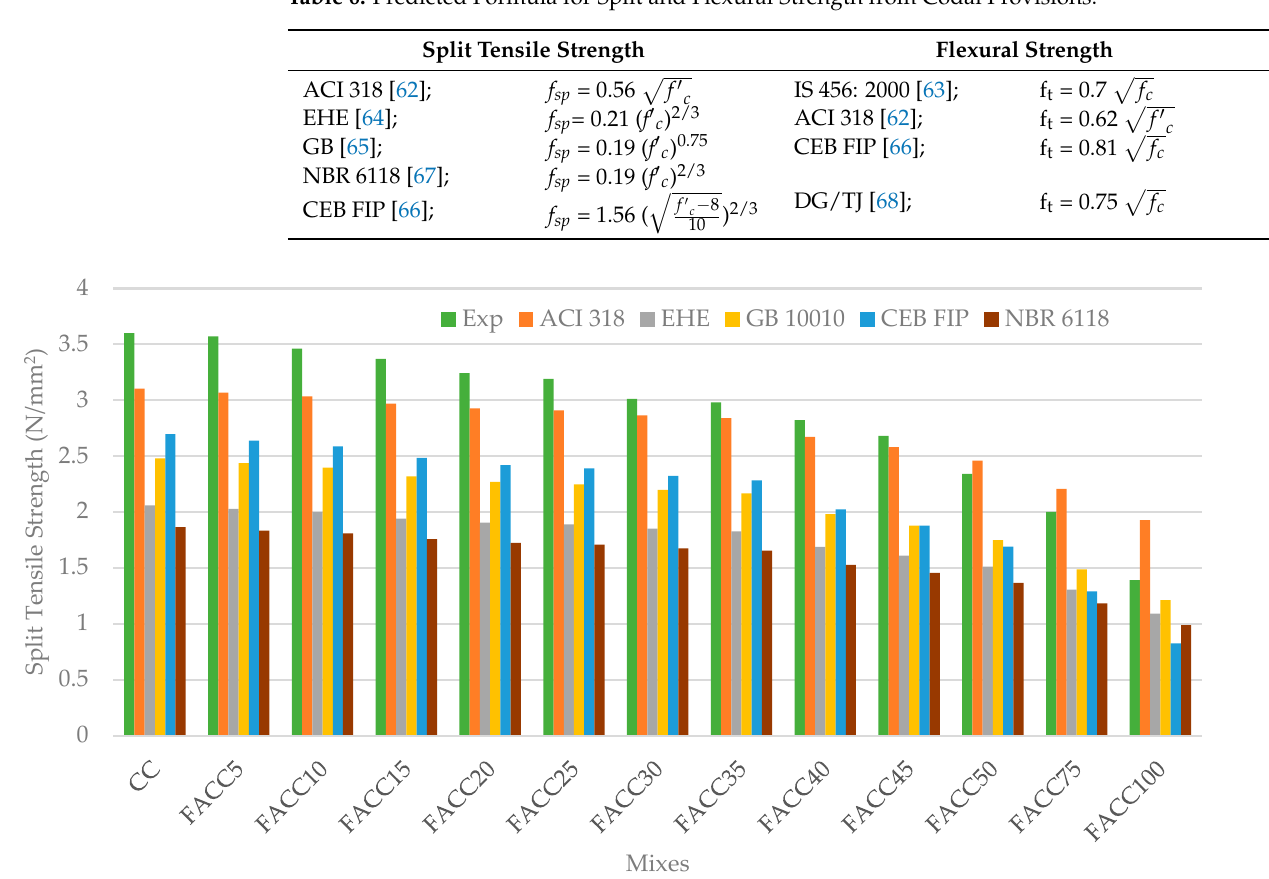
Table 6. Predicted Formula for Split and Flexural Strength from Codal Provisions.